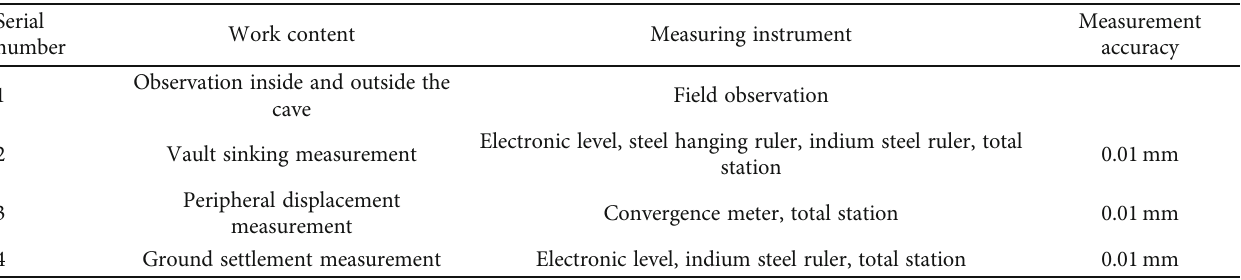
Table 1: Contents of required test items.